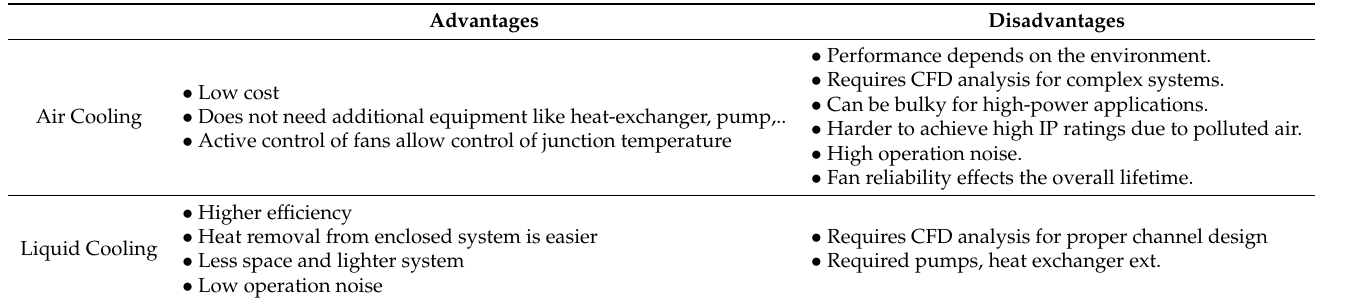
Figure 13. Type of cooling used in the commercially available industrial EV DC-fast charger systems. Table 7. Comparison of air and liquid cooling